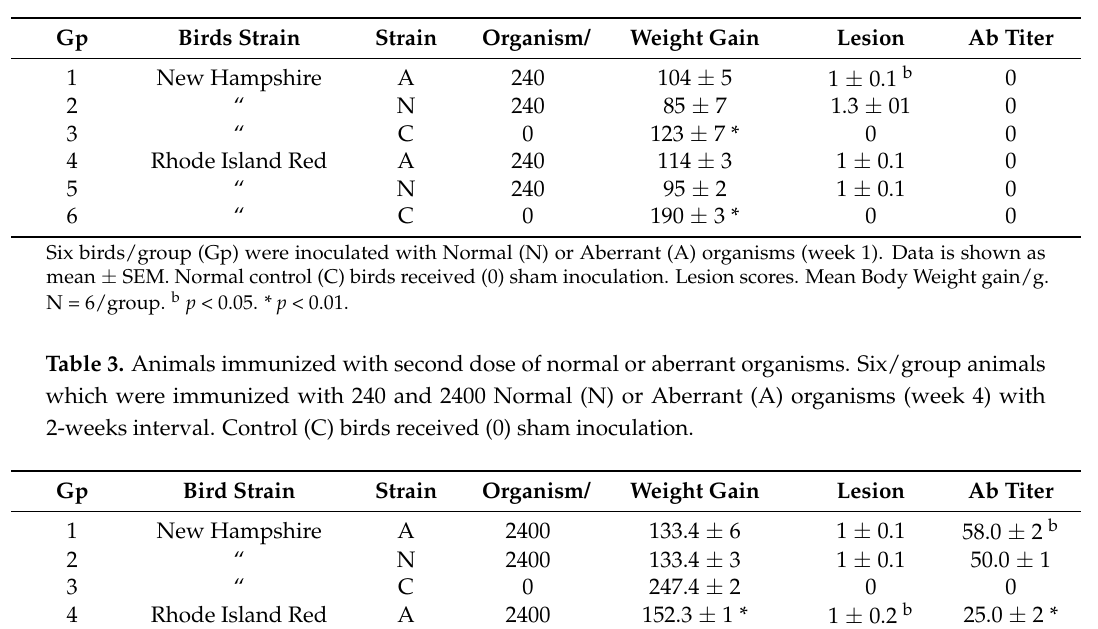
Table 2. Immune-intact animals were immunized with first dose of normal or aberrant organisms at week 1.